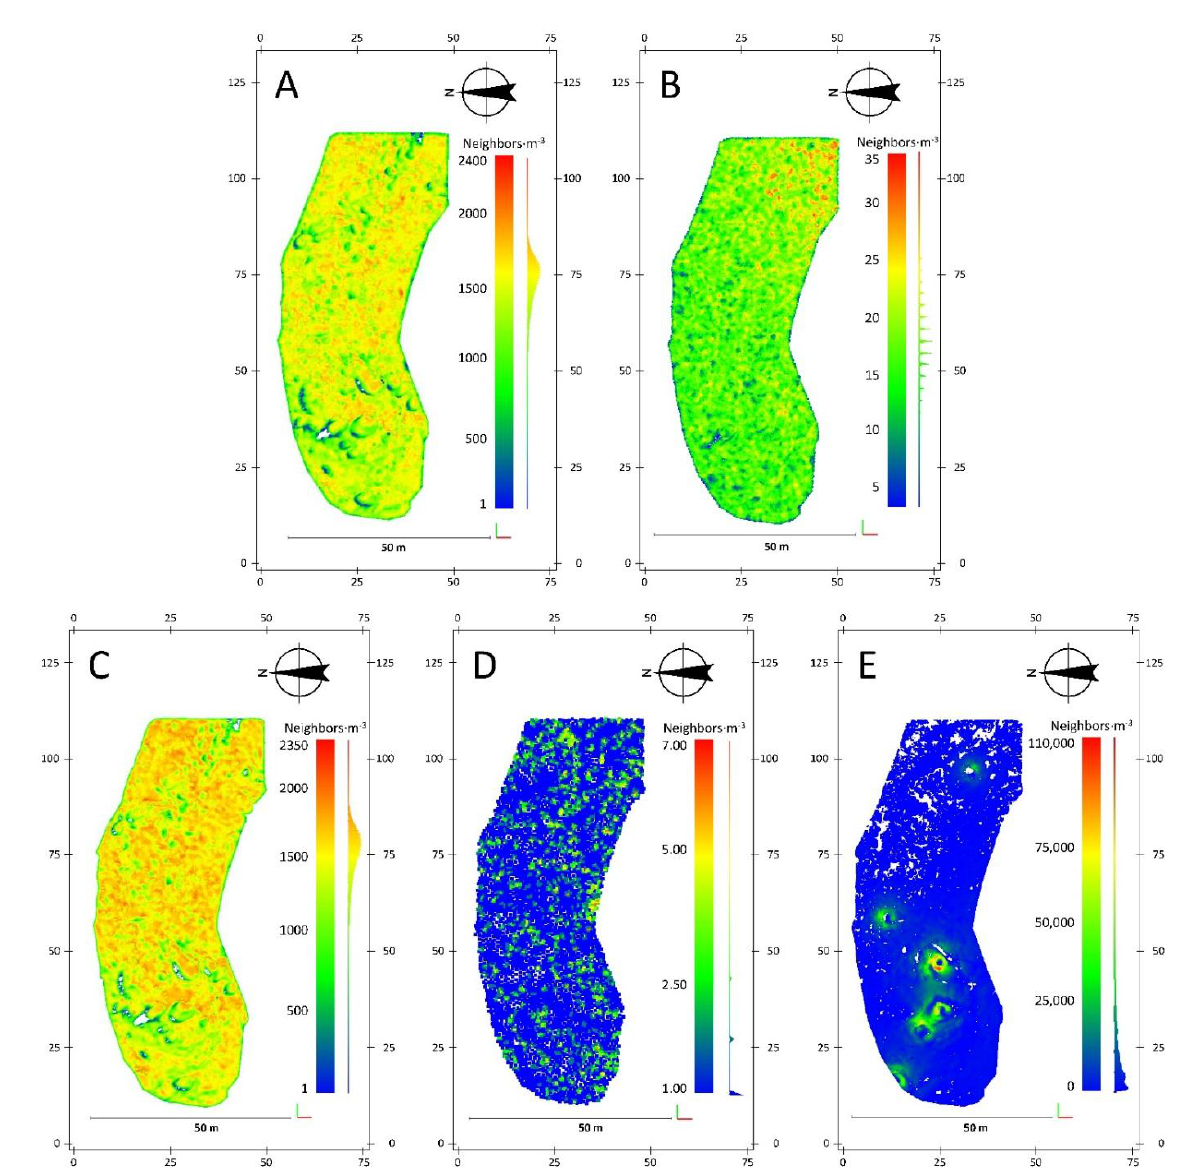
Figure 10. Volumetric point density for the point clouds of the year 2014 and obtained with ( A ) Agisoft Photoscan using Low Dynamic Range (LDR) images, ( B ) 123D Catch using LDR images, ( C ) Agisoft Photoscan using High Dynamic Range (HDR) compositions, ( D ) 123D Catch using HDR compositions and ( E ) the Terrestrial Laser